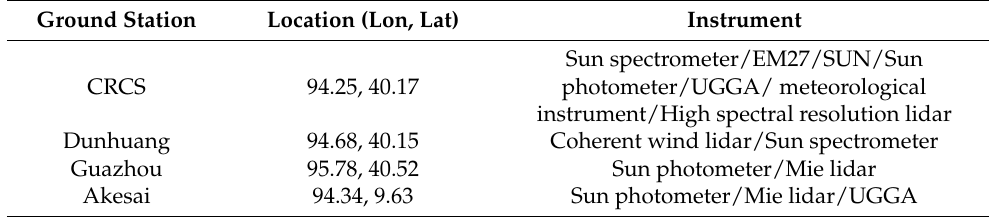
Figure 2. Ground station layout. The solid pink line is the flight route on 19 July 2021. It is worth noting that the Chinese Radiometric Calibration Site (CRCS) (40.17°N, 94.25°E, ~1230 m a.s.l. (above sea level)) is located in the Gobi Desert and approximately 20 km west of Dunhuang city in west China (© Google Earth Pro). Table 1. Layout of the ground